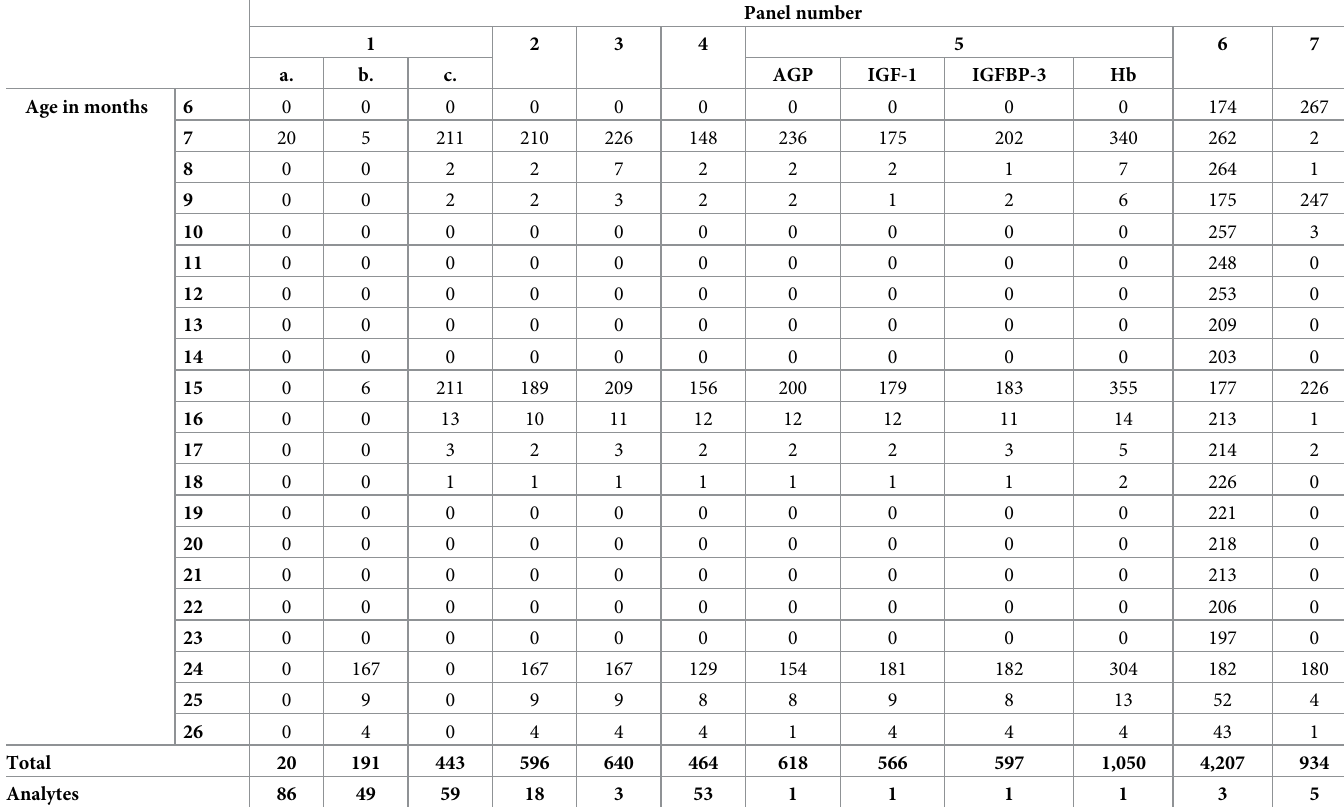
Table 1. Number of biological samples and analytes available in each panel included in the study by age at which they were